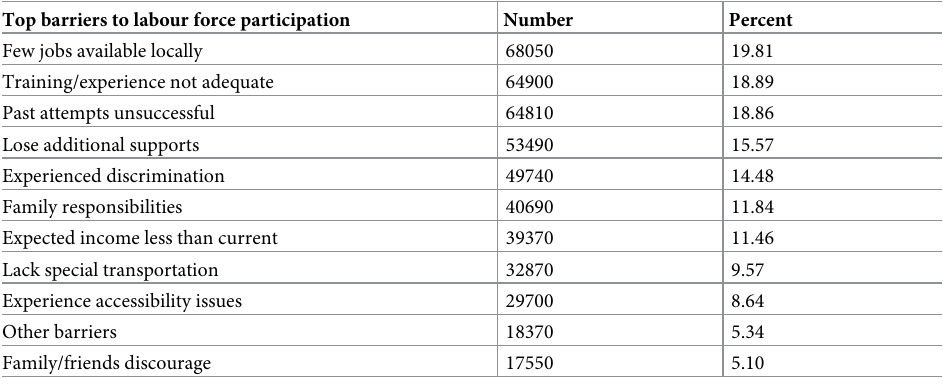
Table 5. Barriers to labour force participation among adults with seeing disabilities (25–64 years), 2017 (N = 885,800).